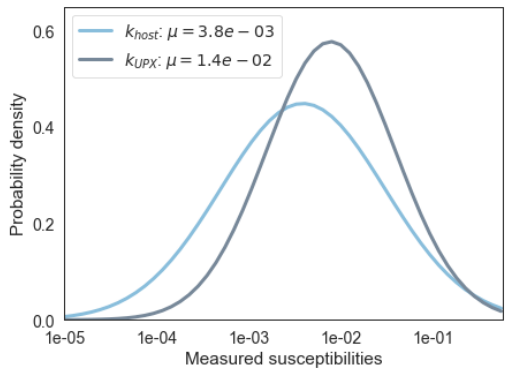
Figure 4. Probability density function (pdf) of downhole measured susceptibilities representing the modeled lithologies ultramafic pyroxenite (UPX) and host rock. Note the logarithmic x-axis.